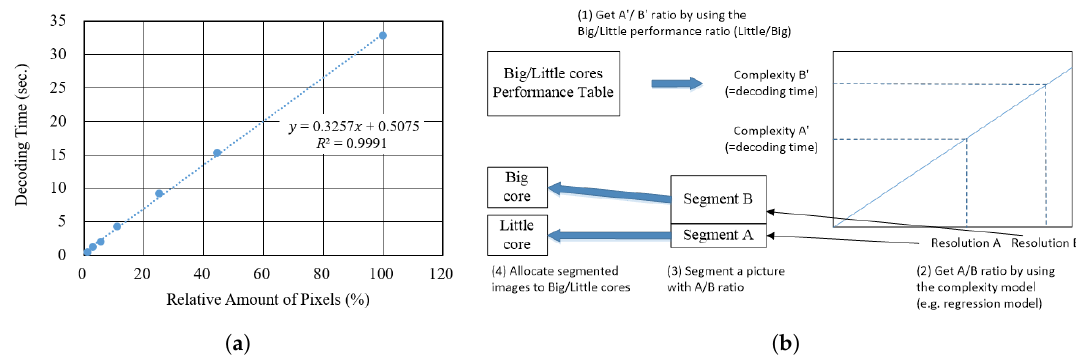
Figure 11. Tile partitioning–based HEVC parallel decoding optimization for asymmetric multicore processors with ( a ) Regression model indicating a correlation between resolutions and decoding complexity, ( b ) The procedure of the proposed non-uniform tile partitioning